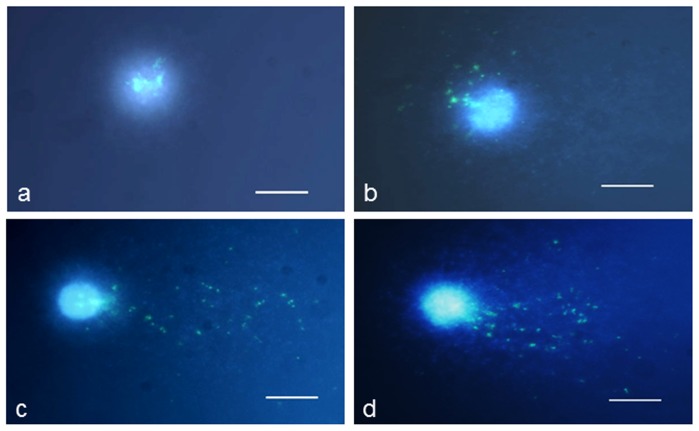
Examples of control and MH-treated nuclei with the distribution of 25S rDNA FISH signals.Bars represent 5 µm.